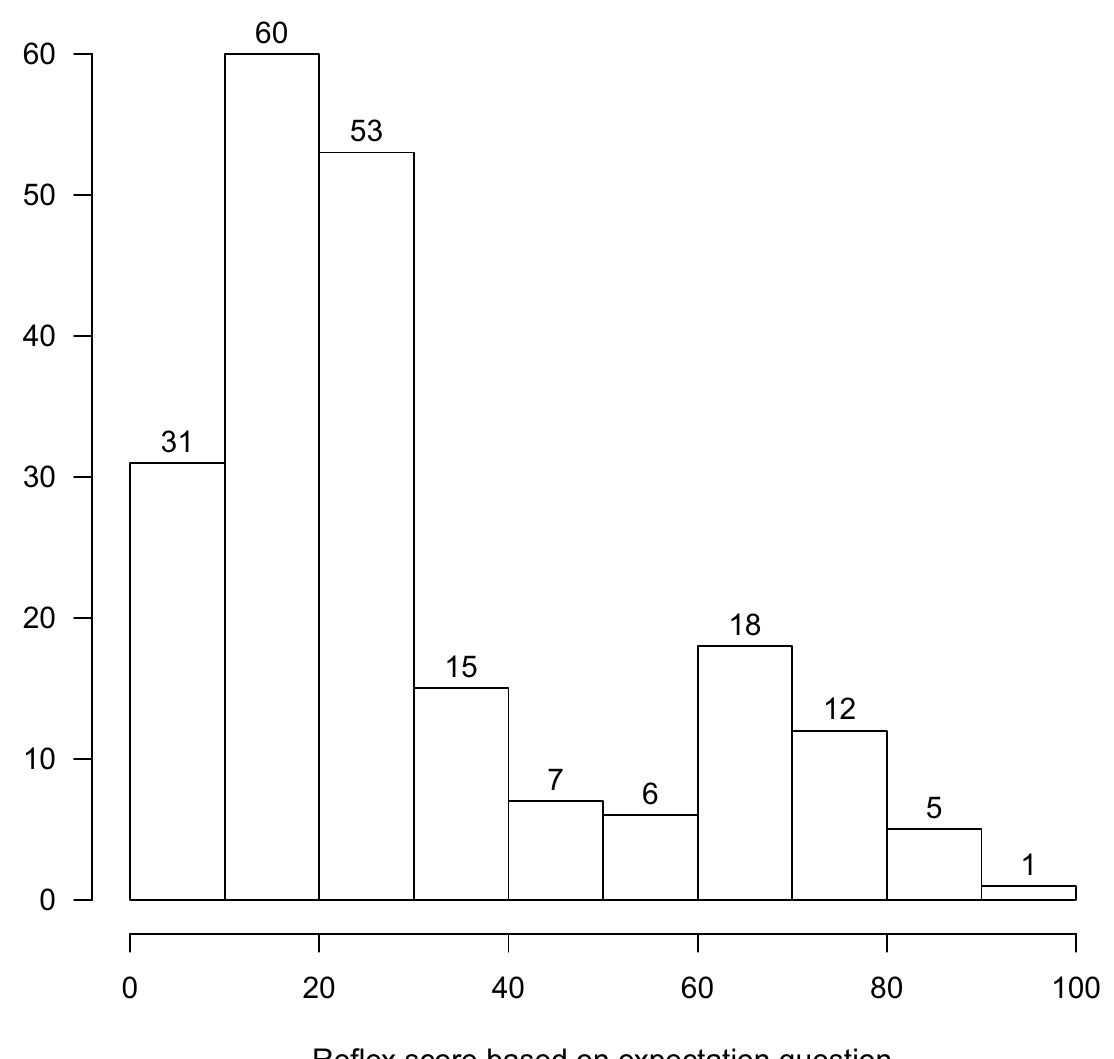
Fig 4. Frequency distribution of hypothetical tVAS scores provided by unique raters from scoring sessions 2–7. N of unique raters is indicated above each bar as it was marked by a rater on their scoresheet in response to a question whether a reflex response would weaken or strengthen when the animal was knowingly exposed to air for a prolonged period (15–30